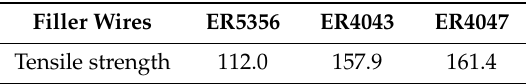
Table 7. Tensile strength of